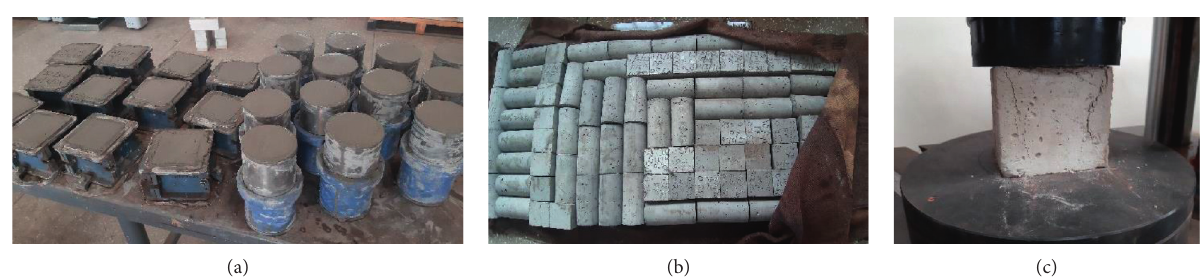
Figure 2: Preparation and testing of specimens. (a) Moulding of specimen. (b) Curing of specimen. (c) Compressive strength test setup.